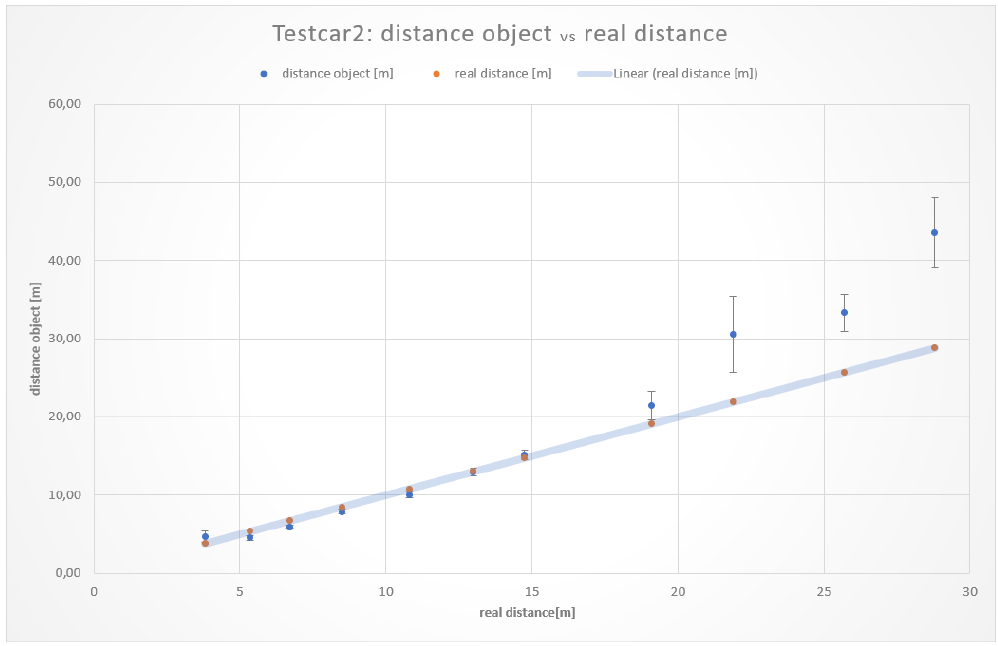
Figure 6. Comparison of the real distance with the measured distance object